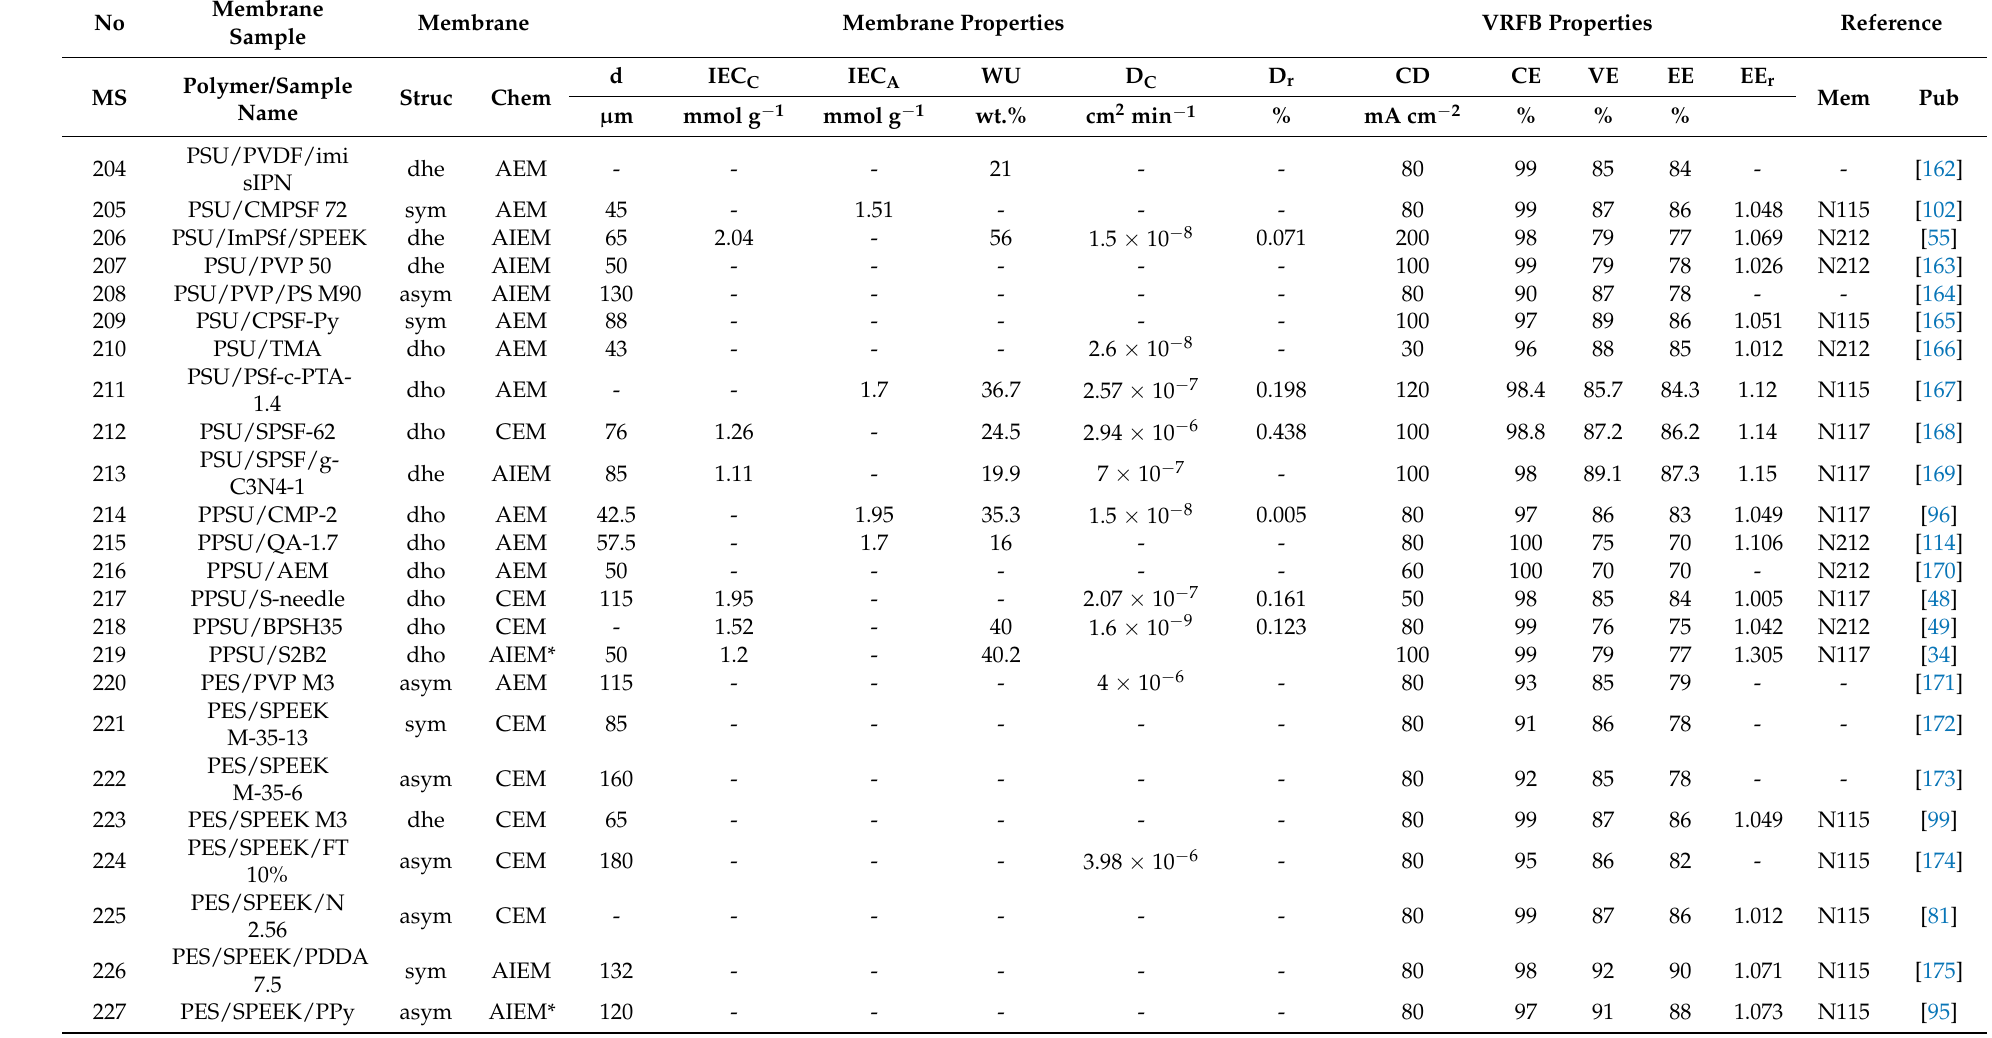
Table 8. List of PSU, PPSU and PES-based hydro-carbon membrane